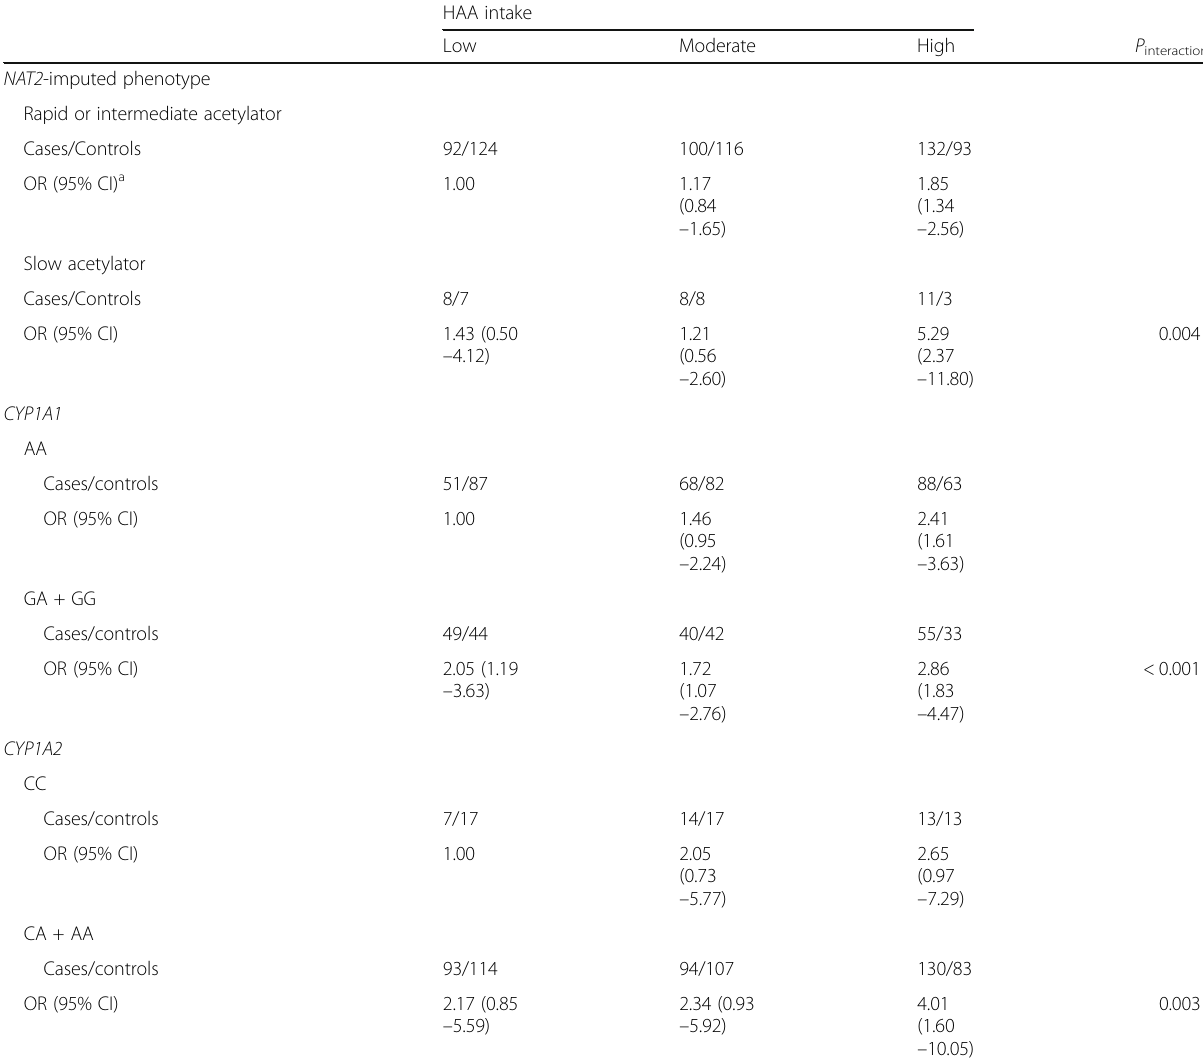
Table 5 Prostate cancer risk and HAA intake stratified by NAT2 -imputed phenotype and CYP1A1 and CYP1A2